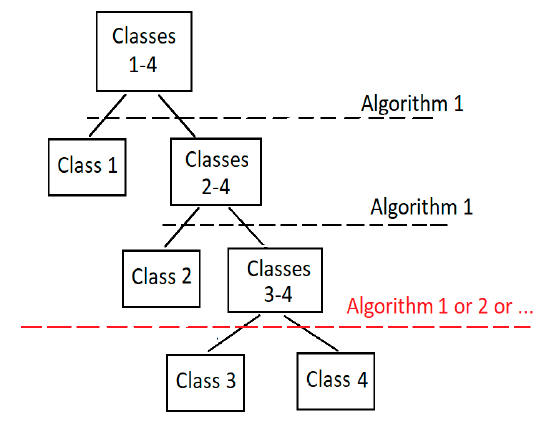
Figure 1. Sub-class-based tree structure.